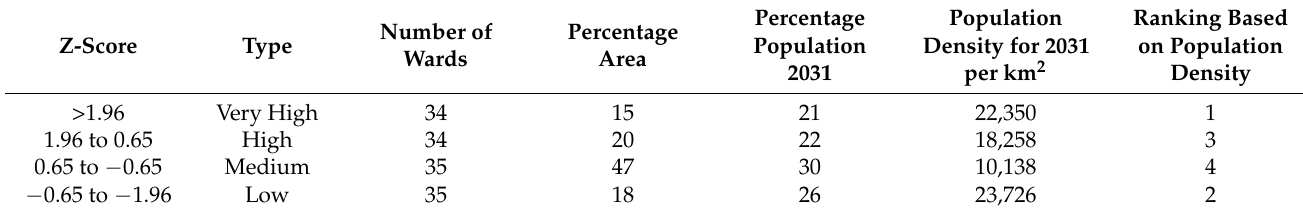
Table 6. Predictive probable fire risk zones.